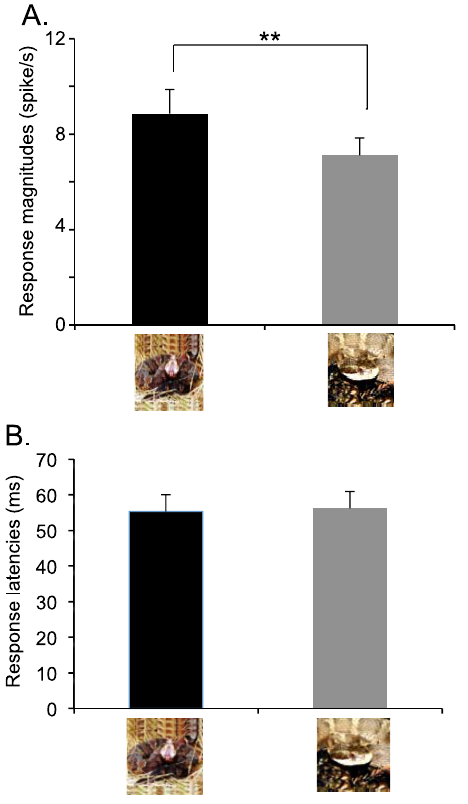
Figure 2. Comparison of mean response magnitudes (n 5 78) (A) and latencies (n 5 52) (B) to the snakes in threat display vs. non-threat-displaying postures. There was no significant difference between response latency to threatening snakes and snakes in non-threat-displaying postures (paired t-test, t(51) 5 0.424, P 5 0.673). In contrast, mean response magnitudes to snakes in threat display were significantly larger than to non-threat-displaying snakes. ** significant difference (paired t-test, t(77) 5 3.056, P 5 0.003). Columns and error bars indicate means with SEM.